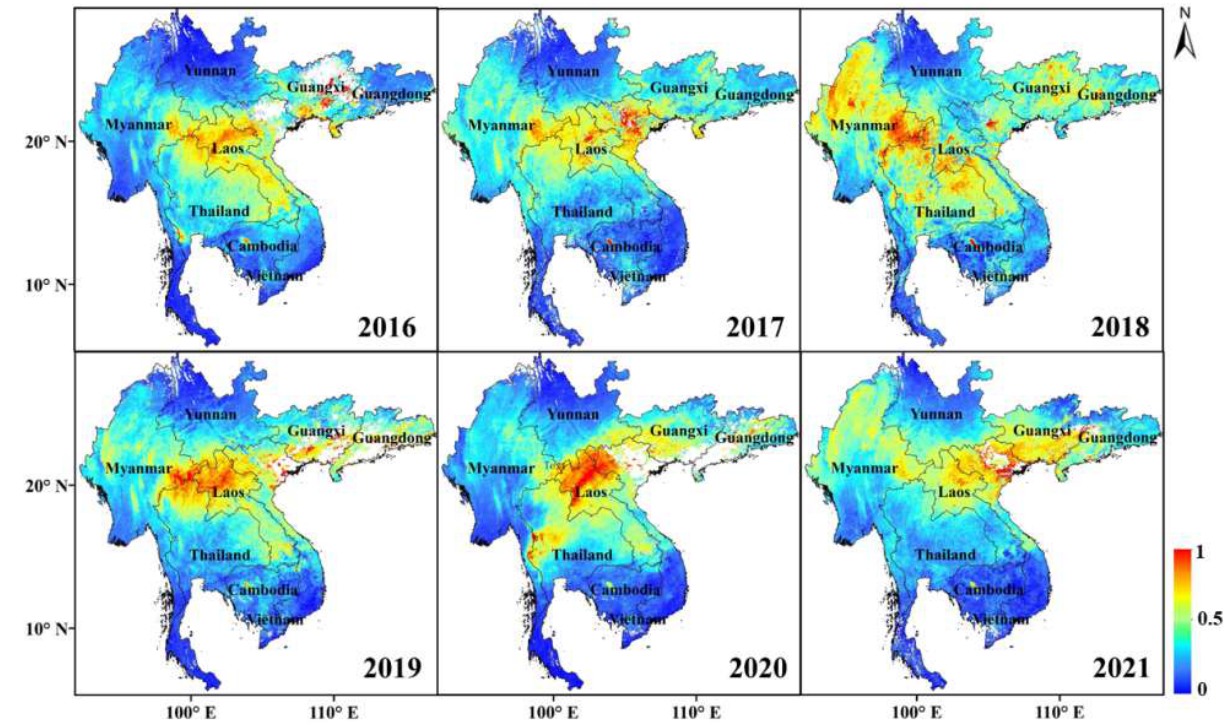
Figure 5. MODIS AOD load changes with time in the study area.